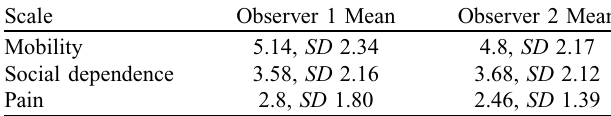
Table 4. Mean scores and standard deviation.